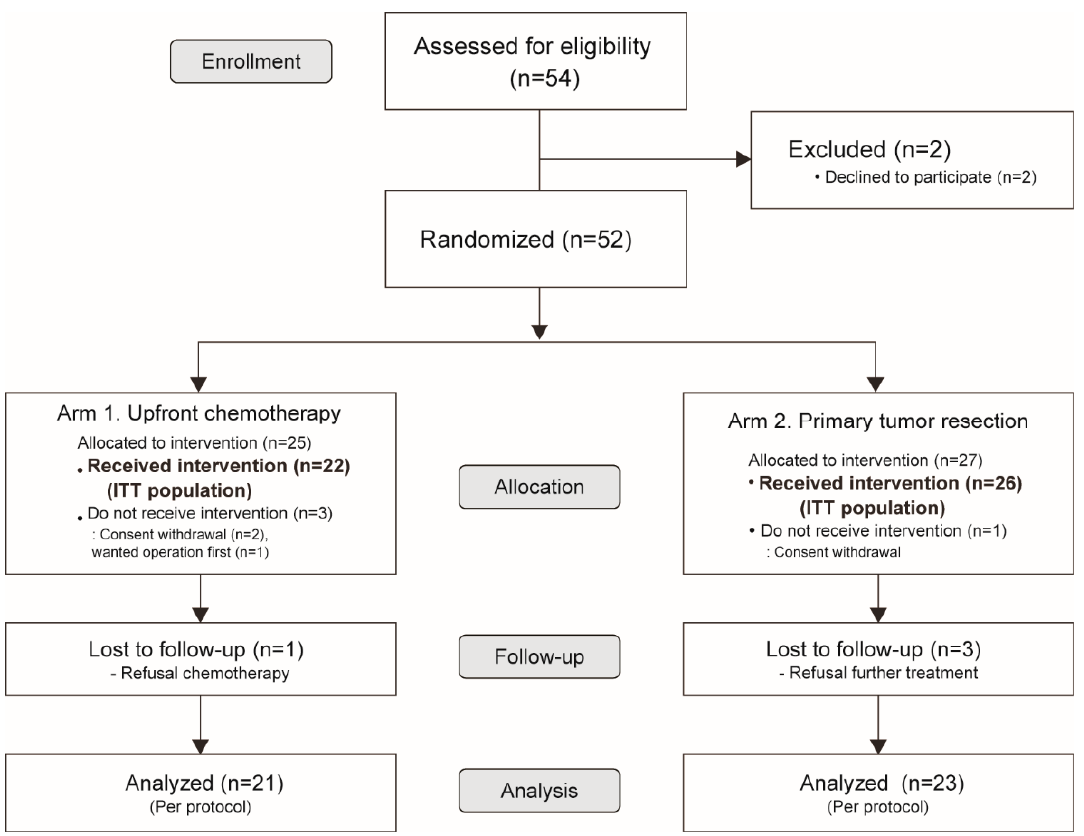
Figure 1. CONSORT flow diagram. ITT, Intention-to-treat.